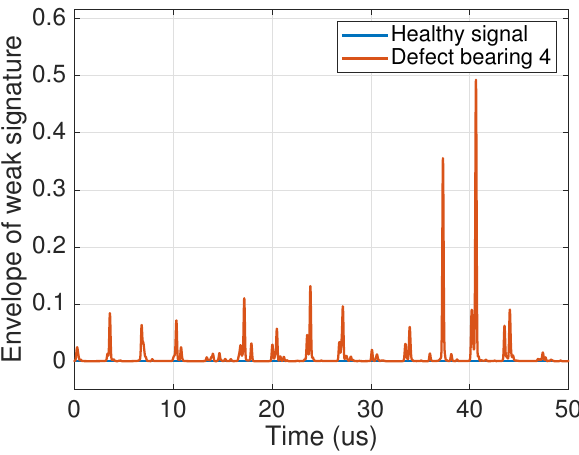
Figure 9. Envelope of the SK filtered